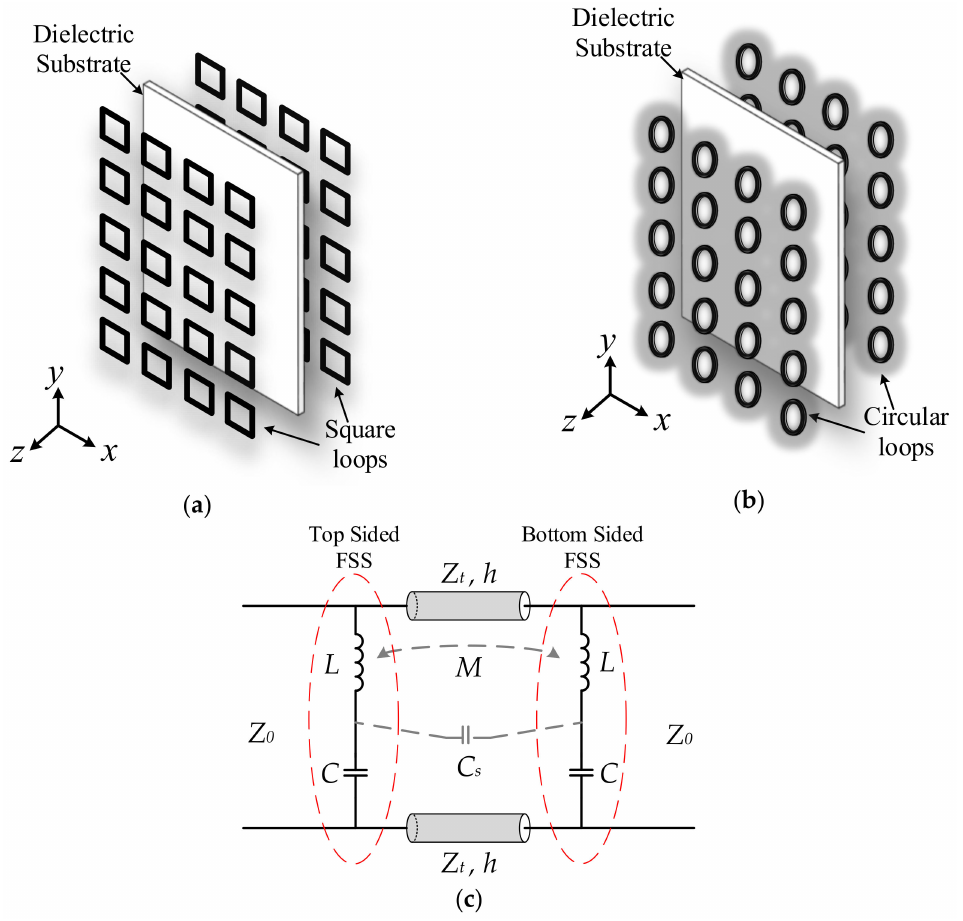
Figure 1. Single-layer double-sided FSSs: ( a ) Layout of a square-loop structure, ( b ) Layout of a circular-loop structure; ( c ) Equivalent circuit